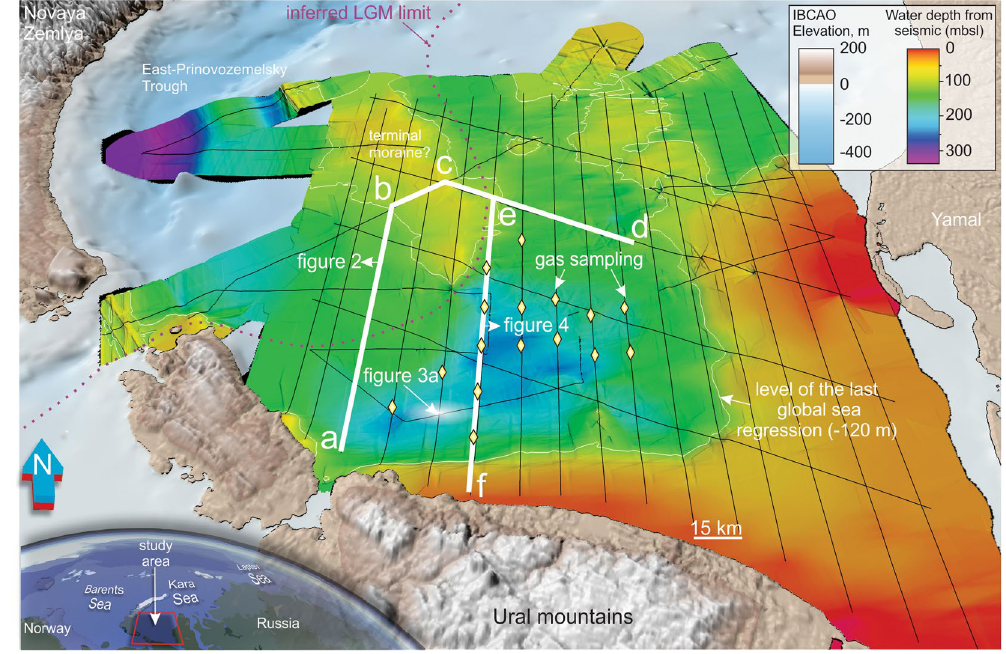
Figure 1. Bathymetry of the South Kara Sea in pale blue color scale (IBCAO v.3) and rainbow color scale (based on high-resolution seismic data). Inset shows the location of the study area (map was generated based on IBCAO v.3 bathymetry grid in Global Mapper v.18 software, http://www.bluemarblegeo.com). Thin black lines show high-resolution seismic grid used in the current study, white thick lines indicate location of seismic profiles, shown in Figs 2 and 4. Yellow diamond shapes show locations of bottom sediment gas-sampling stations used for gas hydrate stability zone modeling. Last Glacial Maximum eastward ice sheet extent 23,24 is indicated with purple dashed